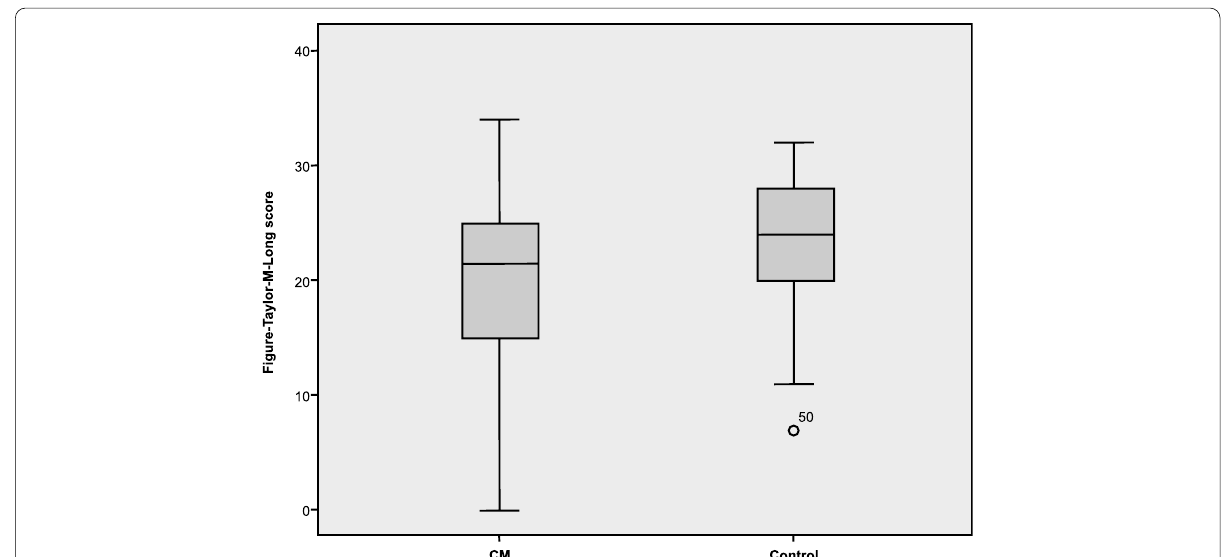
Fig. 4 Results of the Taylor memory task in the CM group and the control group after 3 months of treatment with preventive therapies. Figure‑Taylor‑M‑Long: Taylor Figure test, memory task (longitudinal); CM, chronic migraine